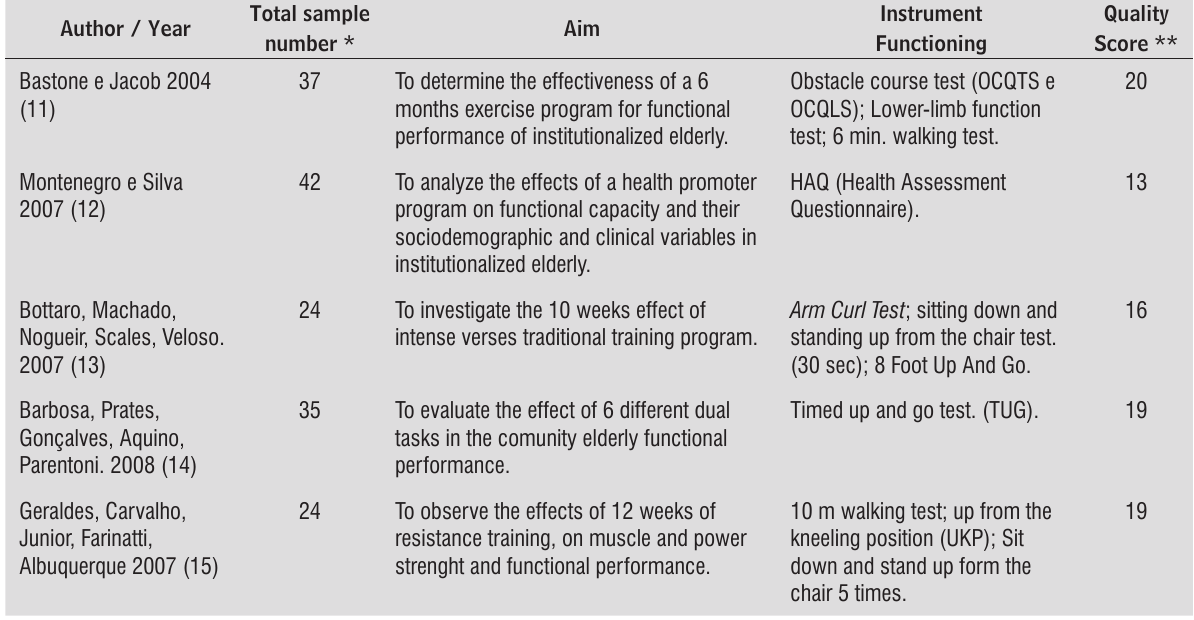
Table 1 - General distribution of the studied articles according to the sample characteristics, aims, functional measurement instrument used and quality